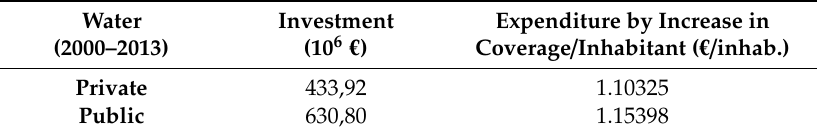
Table 2. Investments made and e ffi ciency of investments in water service.